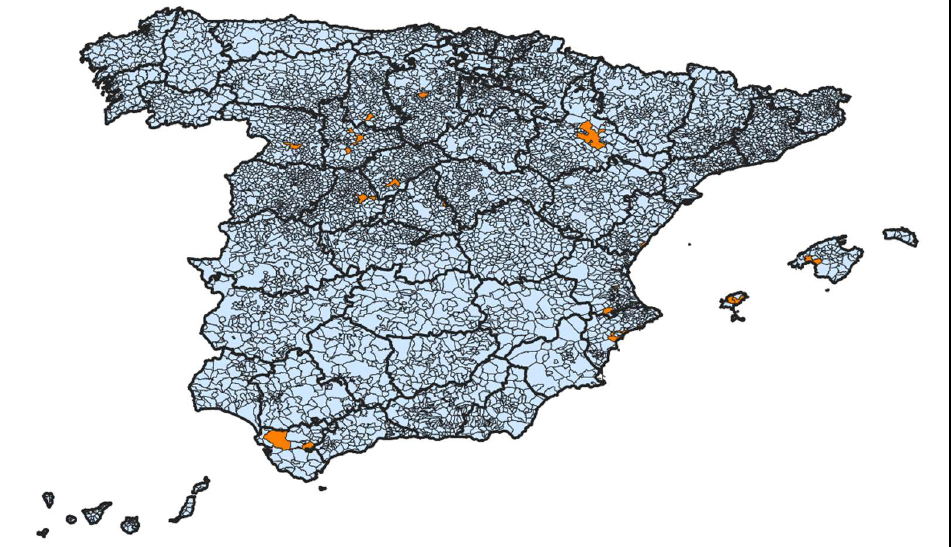
Figure 2. Spatial distribution of MSM-related outbreaks, municipal level.